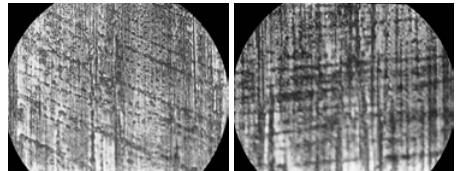
Fig 9. Photomicrography of friction surfaces after the end of plating ( ·